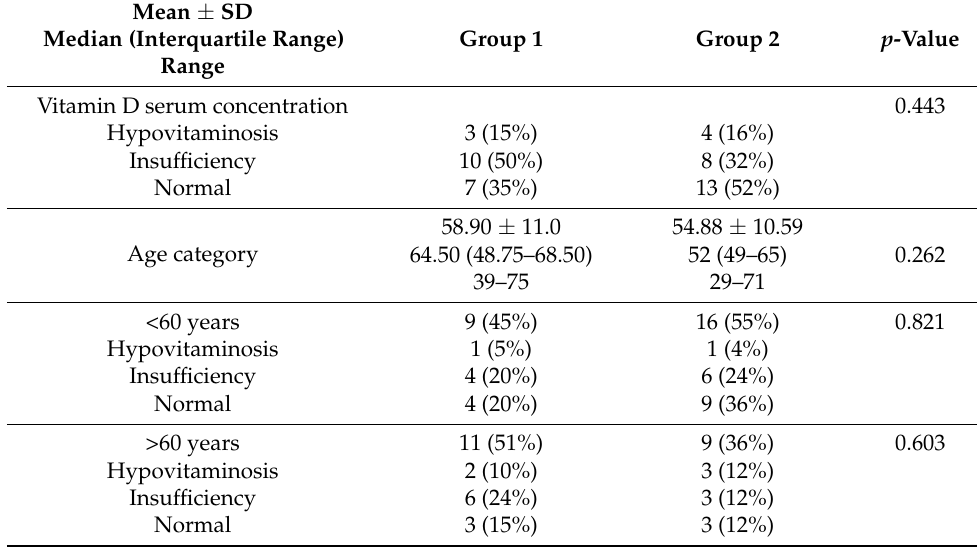
Table 1. General characteristics of patients included in the two psoriasis